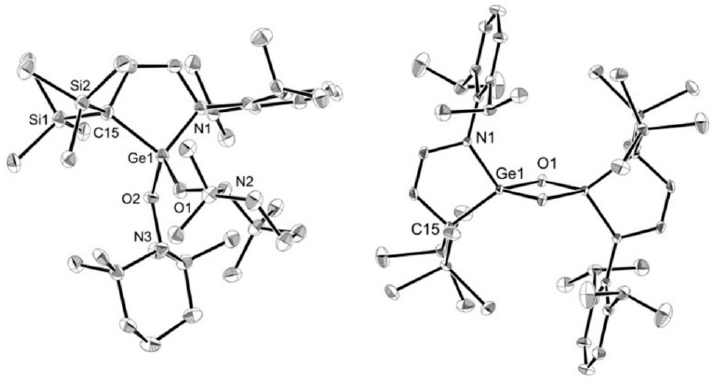
Figure 5. Solid state structures of 4 ( left ) and 5 ( right ). Hydrogen atoms are omitted for clarity. Thermal ellipsoids are shown at the 50% probability level.